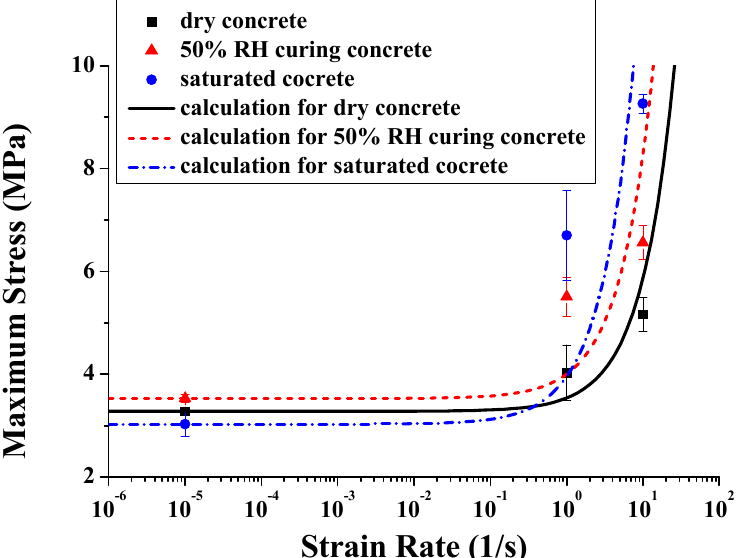
Figure 5: Strain rate effect on maximum tensile stress of concrete with three different curing states. Black squares are the experimental values for dry concrete [5]; black line is predictions of Eq. (2) for dry concrete; red triangles are the experimental values for 50% RH curing concrete [5]; and red dash line is predictions of Eq. (2) for 50% RH curing concrete; blue circles are the experimental values for saturated concrete [5]; blue dash-dot line is predictions of Eq. (2) for saturated concrete.